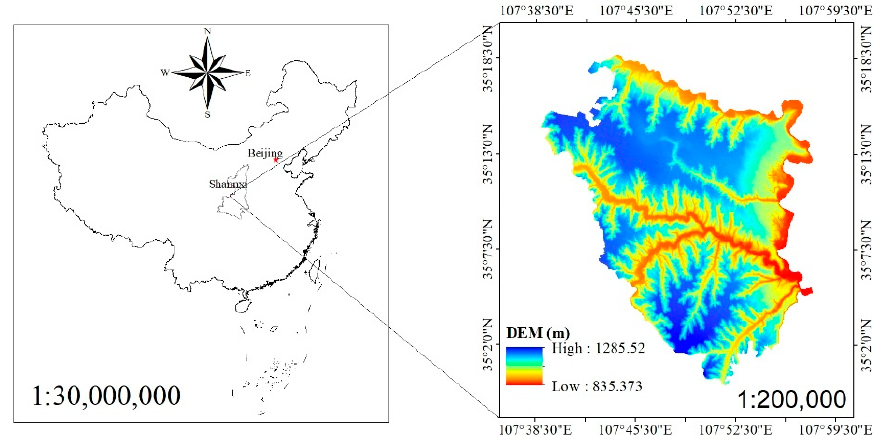
Figure 1. Map of the study area.